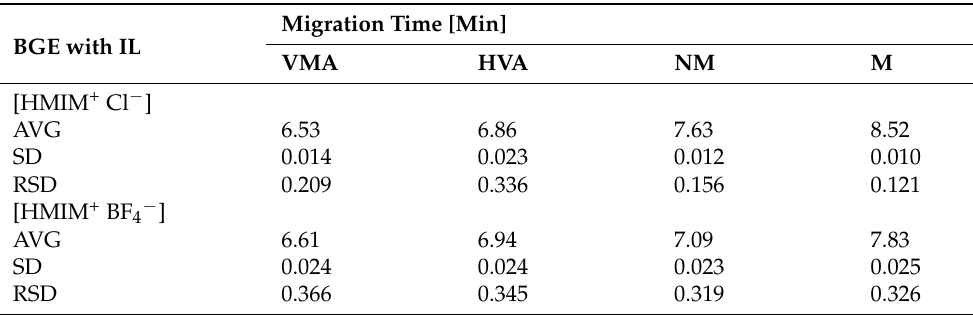
Table 1. Migration times obtained from the analysis of the targeted BAs at a concentration of 10 µ g/mL using BGE with the addition of ILs (n = 3). BGE with